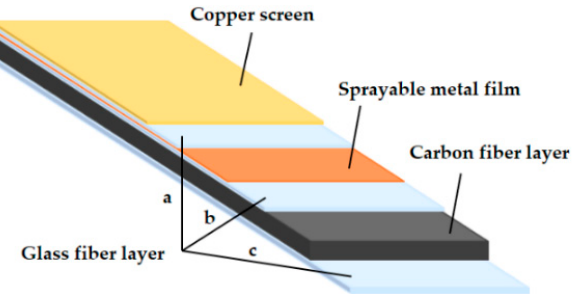
Figure 1. Schematic lay-up of a specimen: (a) for insulation between copper screen and sprayable metal film; (b) for insulation between sprayable metal film and carbon fiber layer; (c) for insulation between carbon fiber layer and the outside Table 1. Material specification .